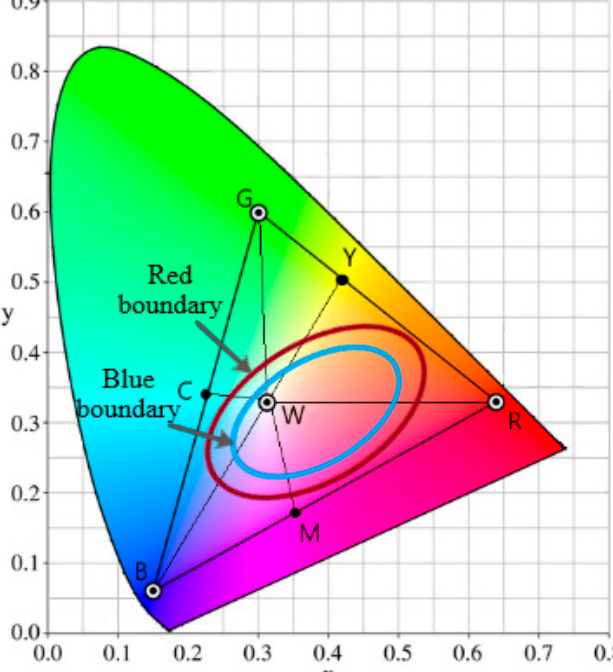
Figure 8. Throat color gamut. Over 98% of the throat color is in the blue boundary. The R, G, B, Y, C, M, and W stands for pure red, green, blue, yellow, cyan, magenta, and white colors, respectively [42].